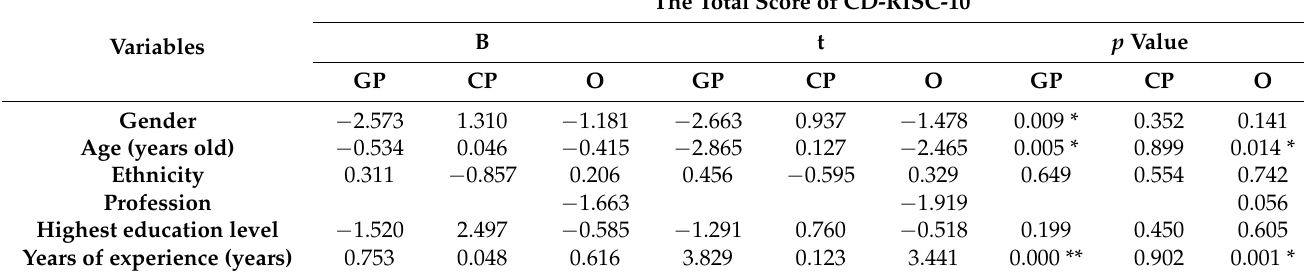
Table 7. Predictors of CD-RISC-10.